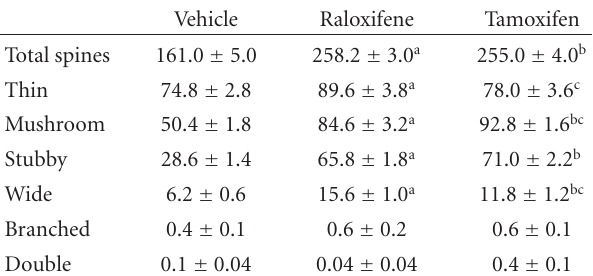
Table 1: Numerical density of dendritic spines in hippocampal CA1 pyramidal neurons of male rats 24 hours after the treatment with vehicle, raloxifene, or tamoxifen.